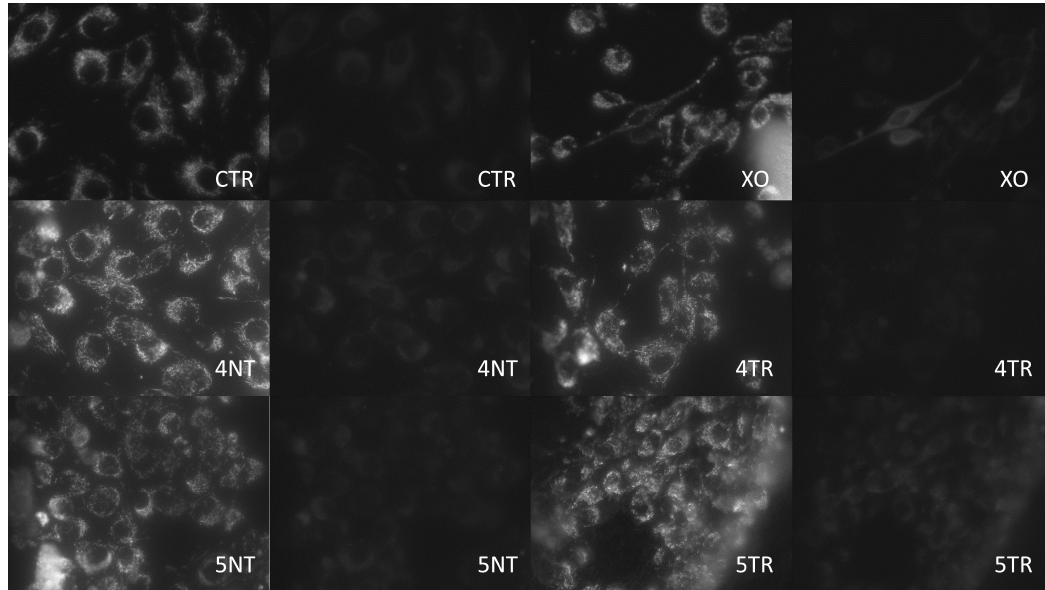
Figure 3. Fluorescence microscopy. Microphotography of the mitochondrial stain in the negative controls (CTR) and positive ones with xanthine oxidase (XO). Mitochondrial damage to MG-63 cells on the 4TR was higher than in the 4NT group; higher mitochondrial damage was observed on the 5NT group compared to the 5TR group (40× magnification).